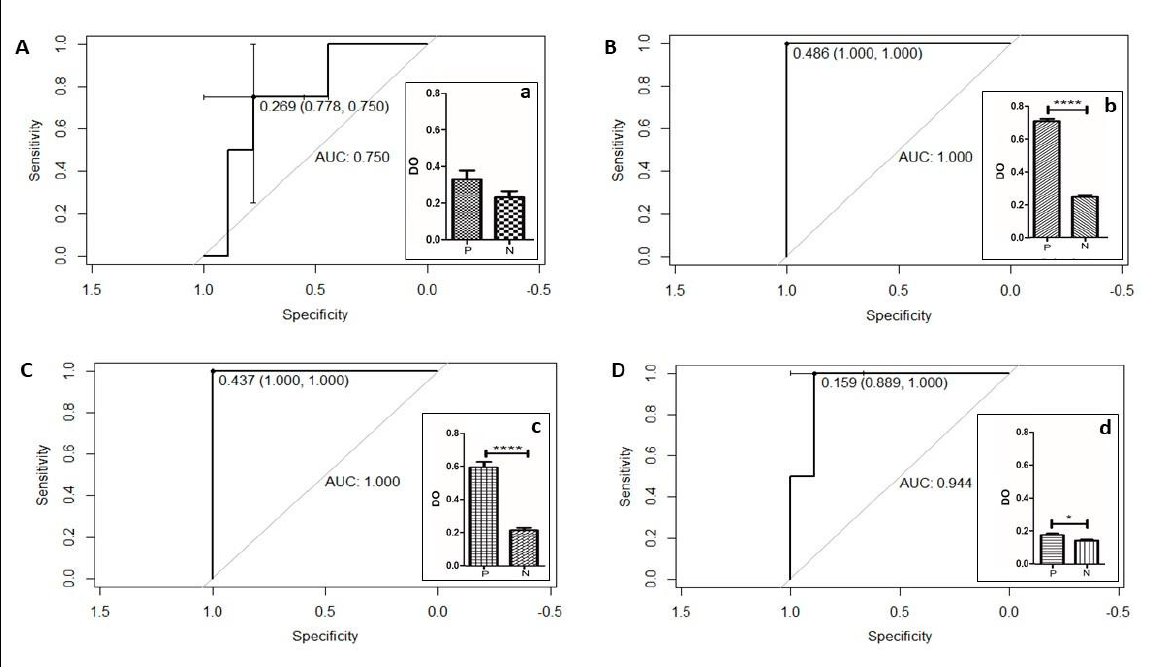
Figure 5. Statistical parameters of the four protocols of bacterial inoculum preparation: ( A ) ROC DC curve with cut-o ff 0.269, sensitivity: 77.8%, and speci fi city: 75%; ( a ) t -test p -value < 0.05; ( B ) ROC PD-OD1 curve, cut-o ff of 0.486, sensitivity of 100%, and speci fi city of 100%; ( b ) t -test **** p -value <